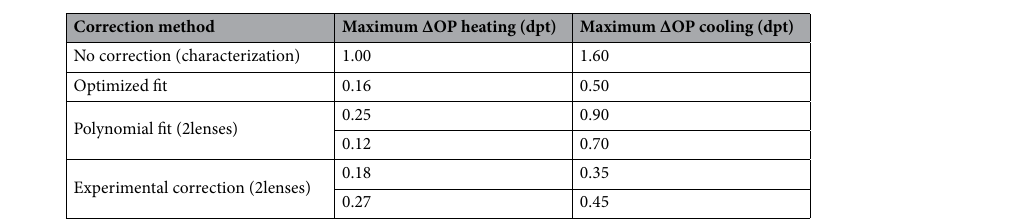
Table 1. Summary results of optical power deviation for the three models and repetition